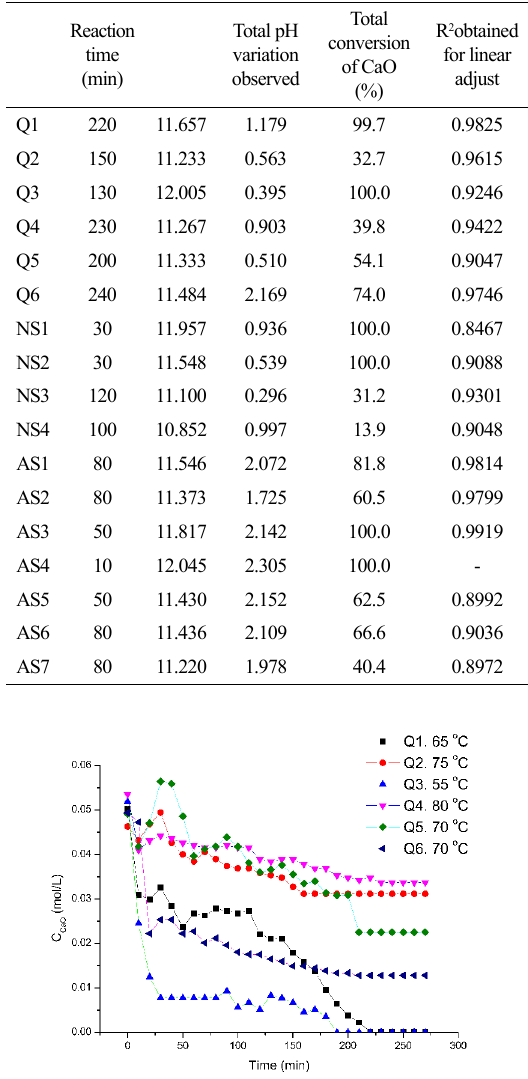
Table 4. Summary of results obtained.